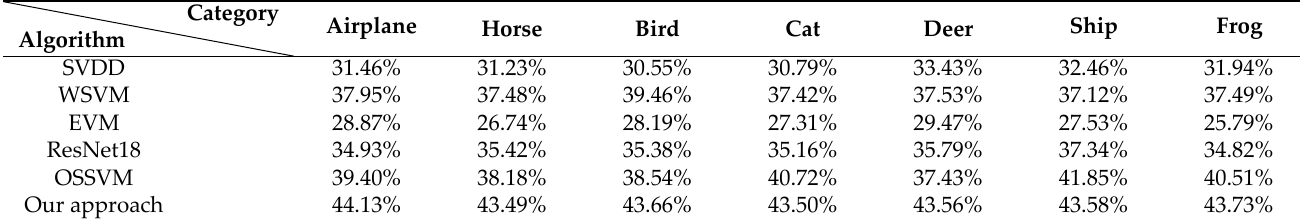
Table 1. Comparison of F1‑measure values of some categories in CIFAR100 open dataset.